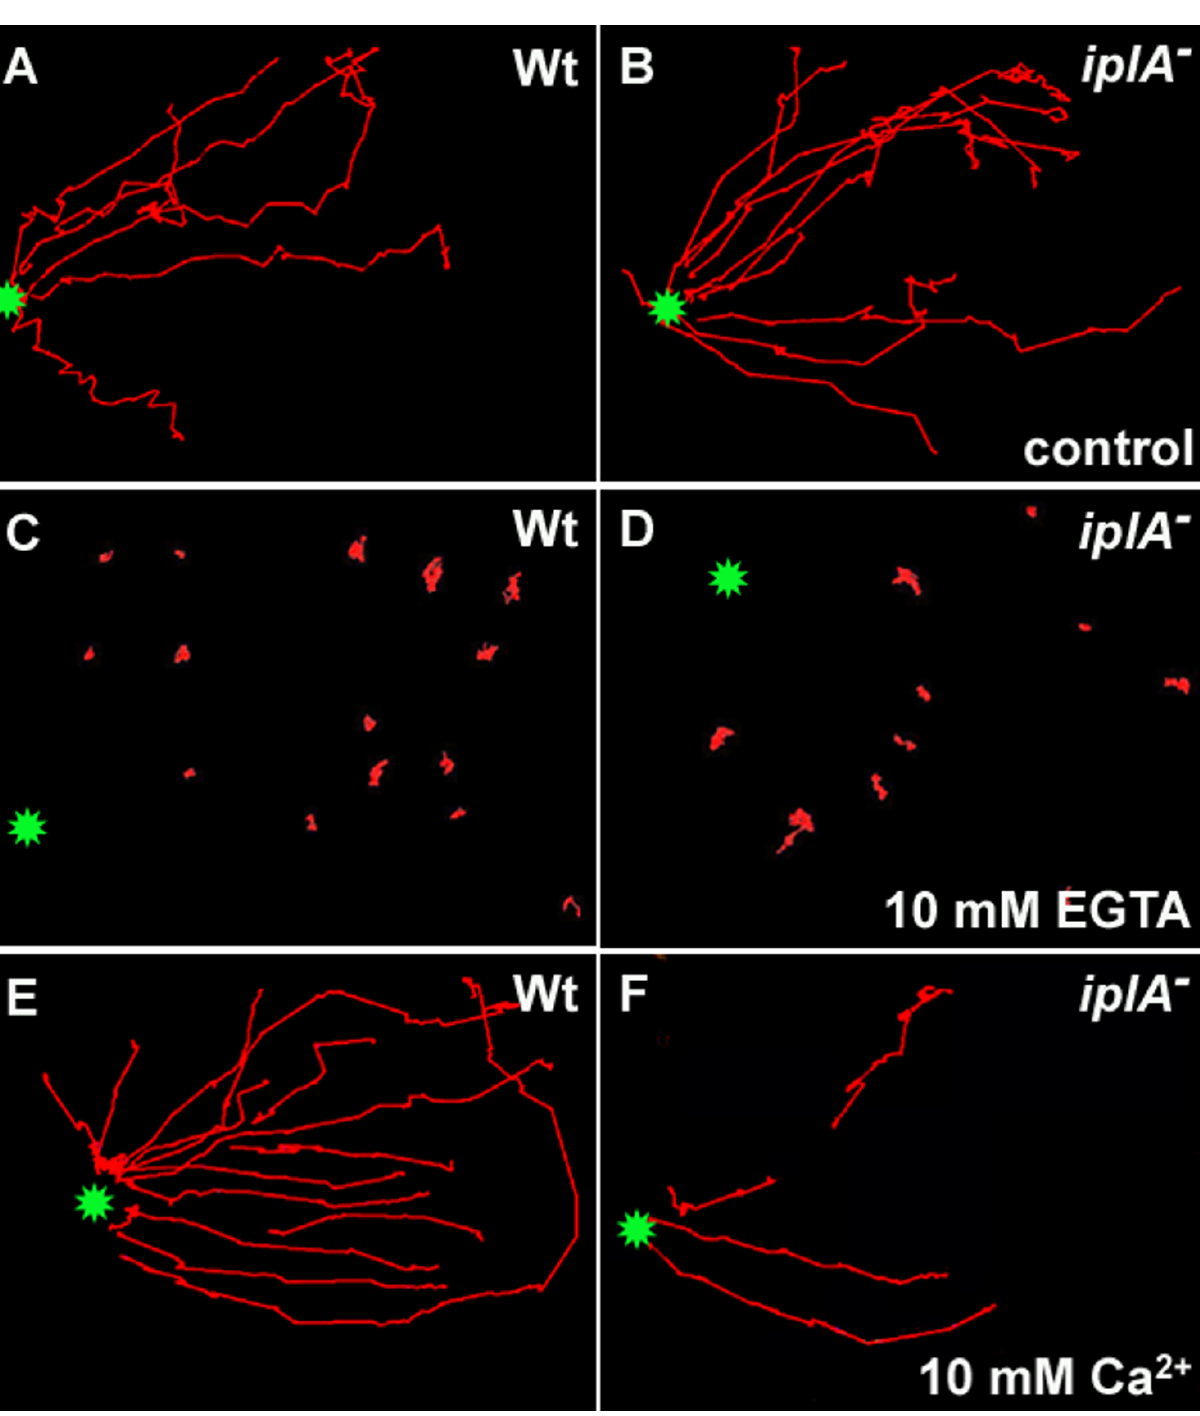
(E, F) did not impair chemotaxis; 2 6